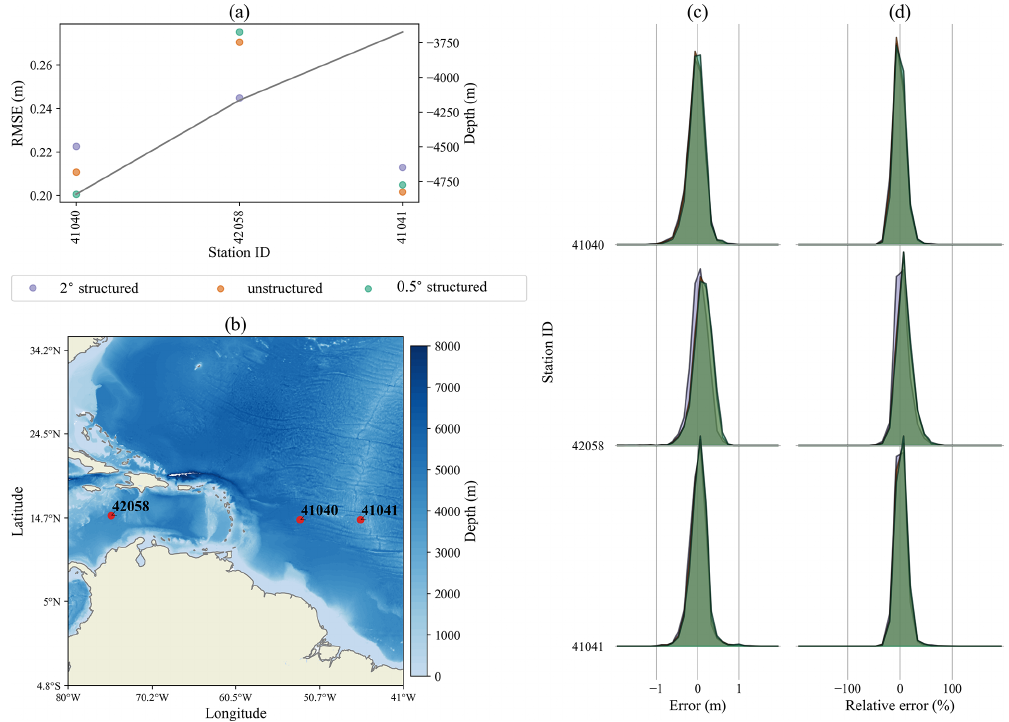
Figure 6. Same as Fig. 3 for stations in the Caribbean Sea and Atlantic